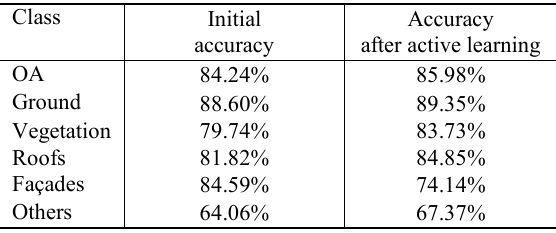
Table 2. Accuracy comparison of classification using initial